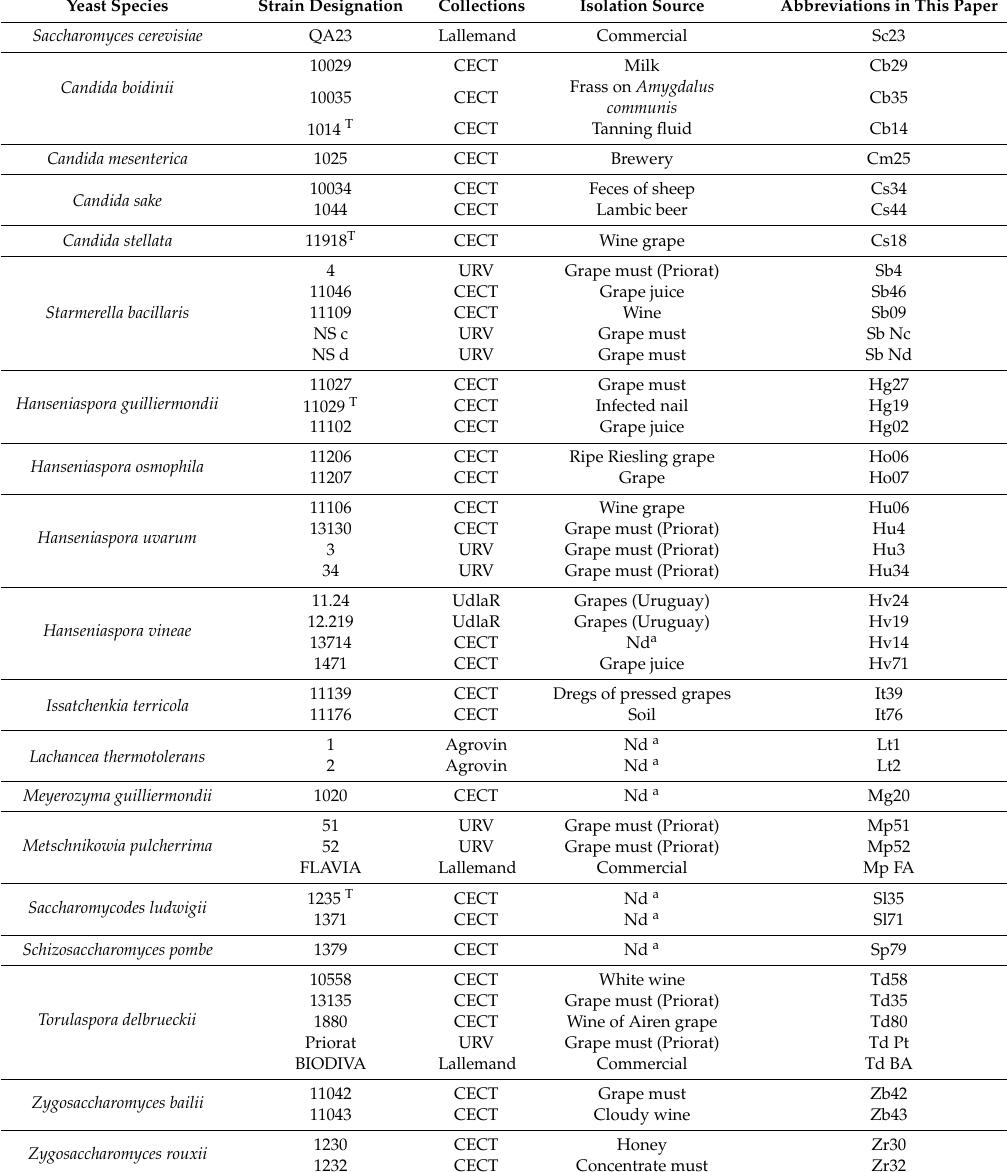
Table 1. Yeast strains used in this study (CECT, Spanish Type Culture Collection; URV, our group yeast collection, some of them isolated in Priorat Appelation of origin [39]; UdlaR, Universidad de la Rep ú blica yeast collection, Uruguay; Agrovin S.A, Ciudad Real, Spain; Lallemand, Lallemand Inc. Montreal,